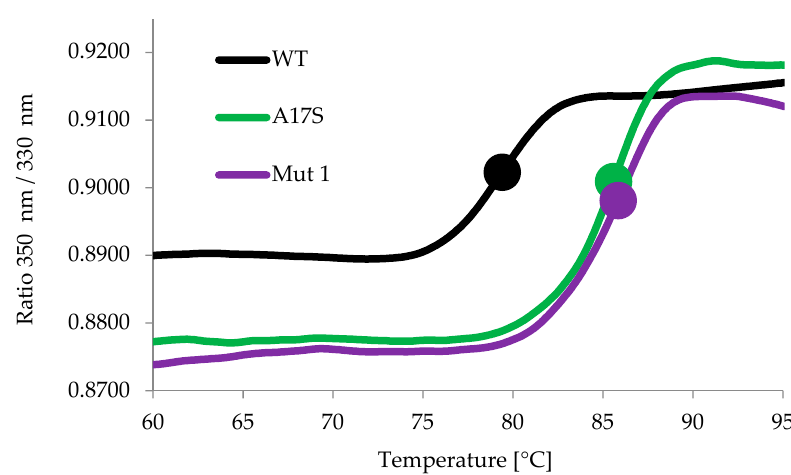
Figure 2. Inflection temperatures (T i ) of wild-type (WT) C. thermocellum BglA, Mut 1 and A17S. The inflection temperatures were measured using a NanoTemper Tycho NT.6 instrument as described in the Methods section.